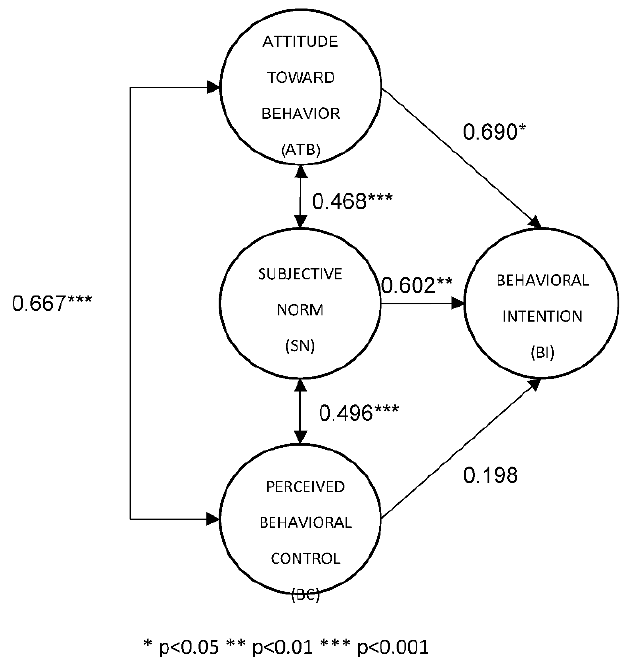
Figure 3. Research hypothesis testing. * Probability test value less than 0.05, ** Probability test value less than 0.01, *** Probability test value less than 0.001